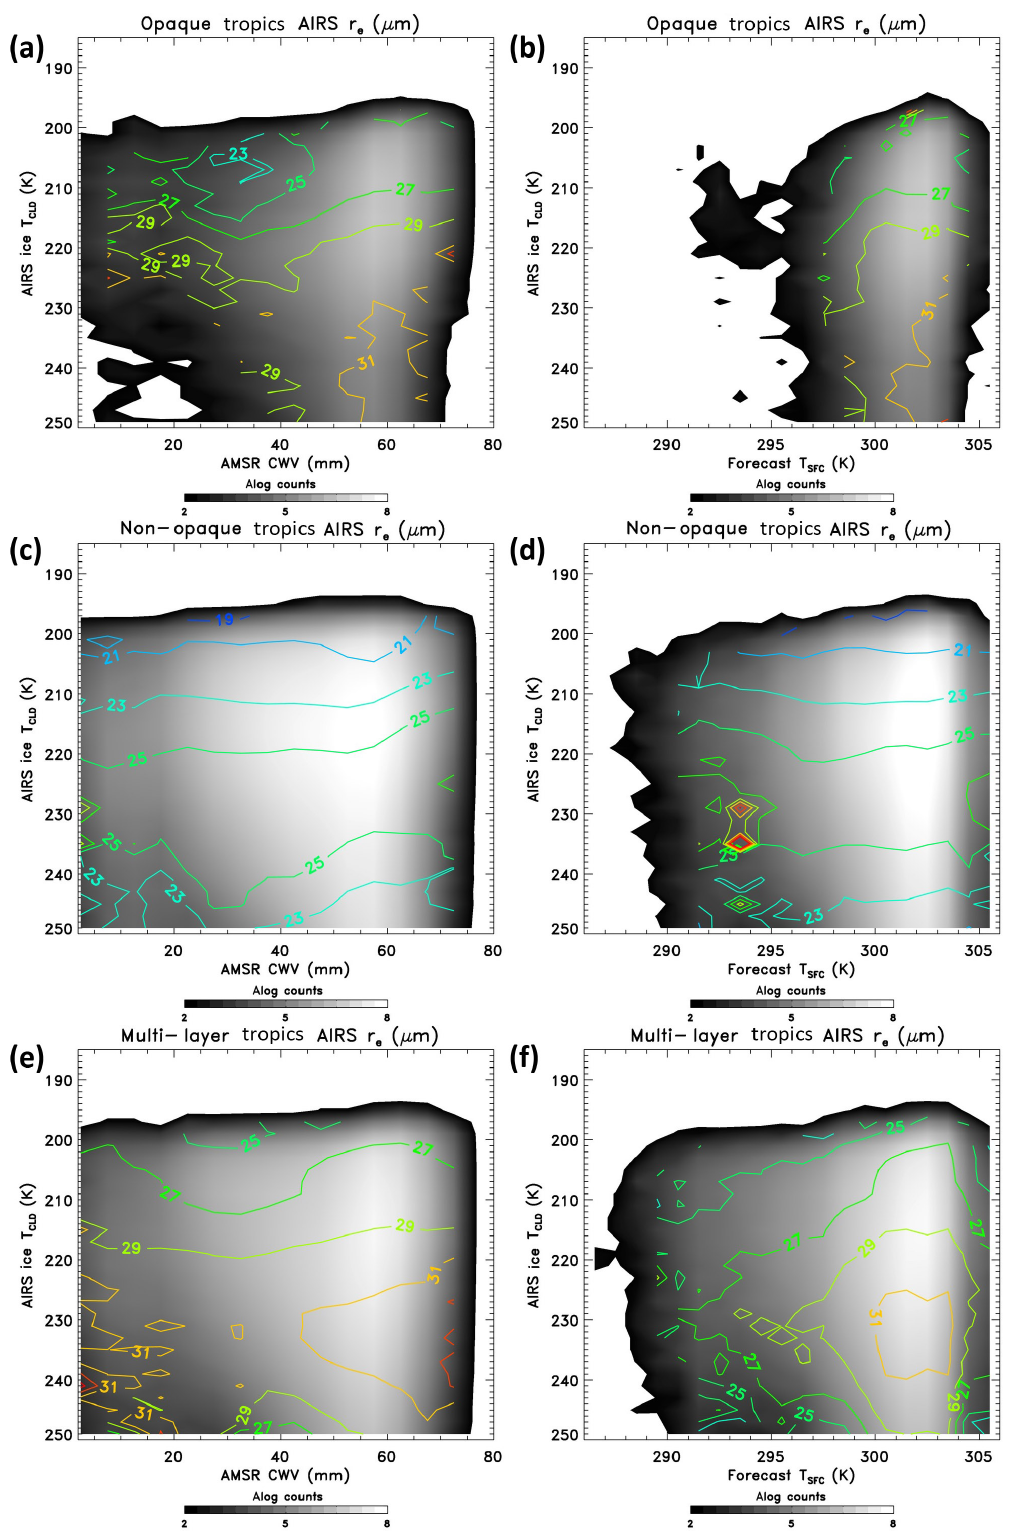
Figure 10. AMSR-E/AMSR-2 total CWV (mm) (a, c, e) or T sfc (K) (b, d, f) vs. T cld histograms. The log counts are shown as a greyscale, the AIRS IR only r ei (µm) overlaid as colored contours, with opaque (a, b) , non-opaque (c, d) , and multi-layered (e, f) clouds shown separately.